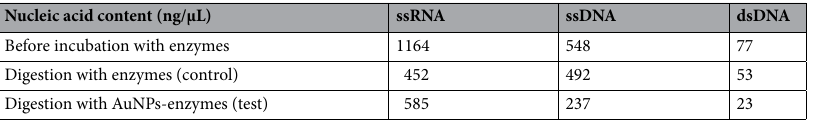
Table 2. Concentrations of ssRNA, ssDNA, and dsDNA in samples before and after incubation with enzymes and AuNPs-enzymes.